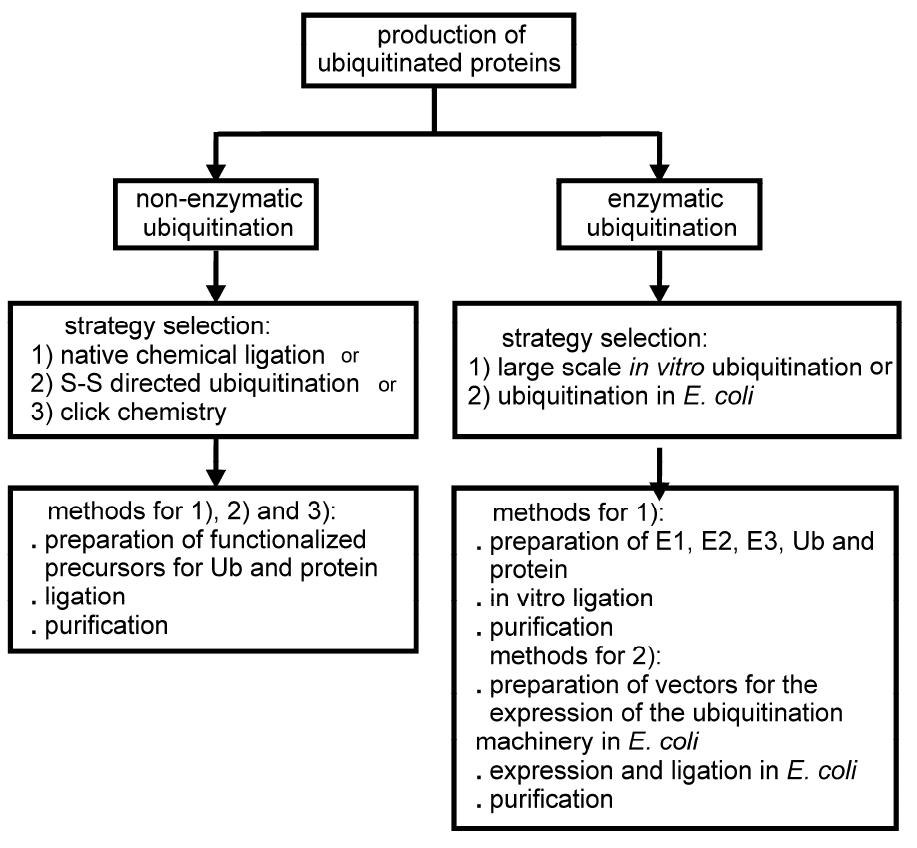
Figure 1. Schematic flow chart of the possible approaches developed so far for the production of mono-ubiquitinated proteins for biochemical and structural